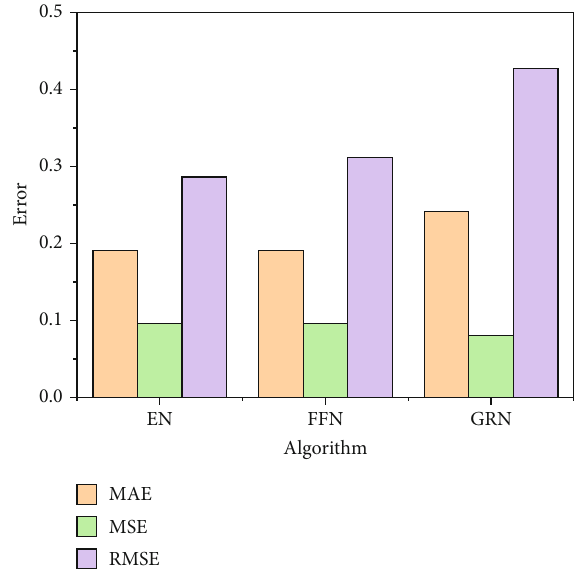
Figure 12: Performance metrics of the proposed algorithm for the BISTPV